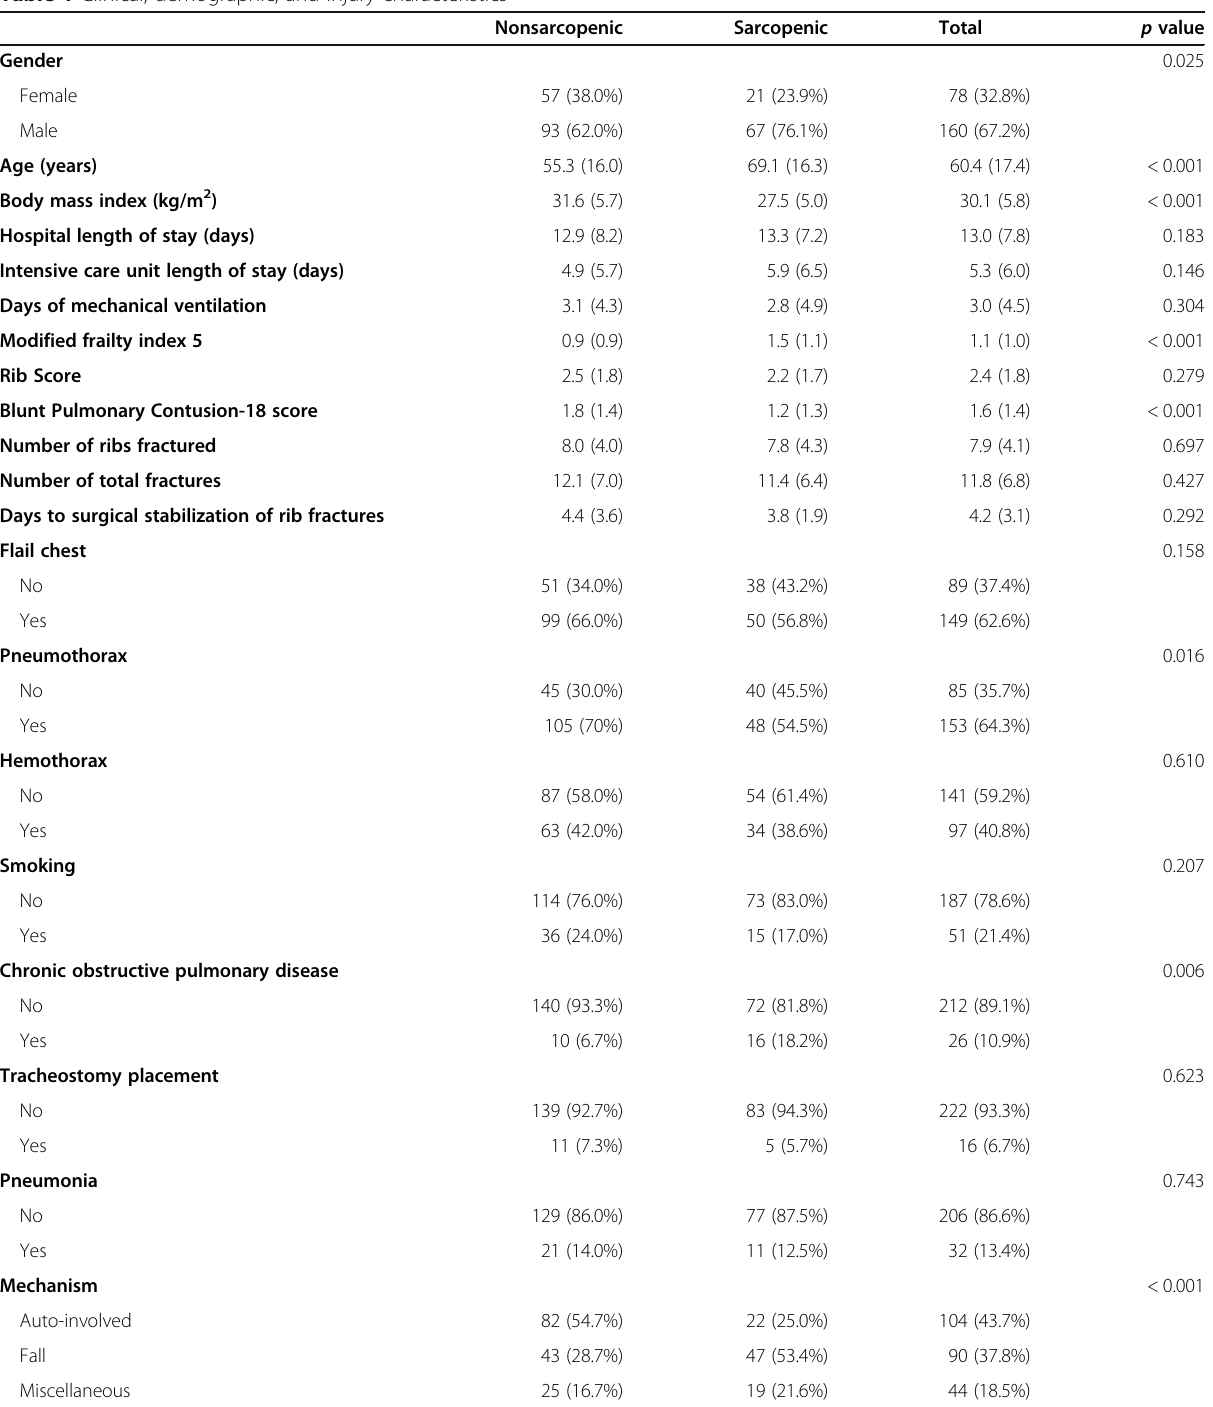
Table 1 Clinical, demographic, and injury characteristics